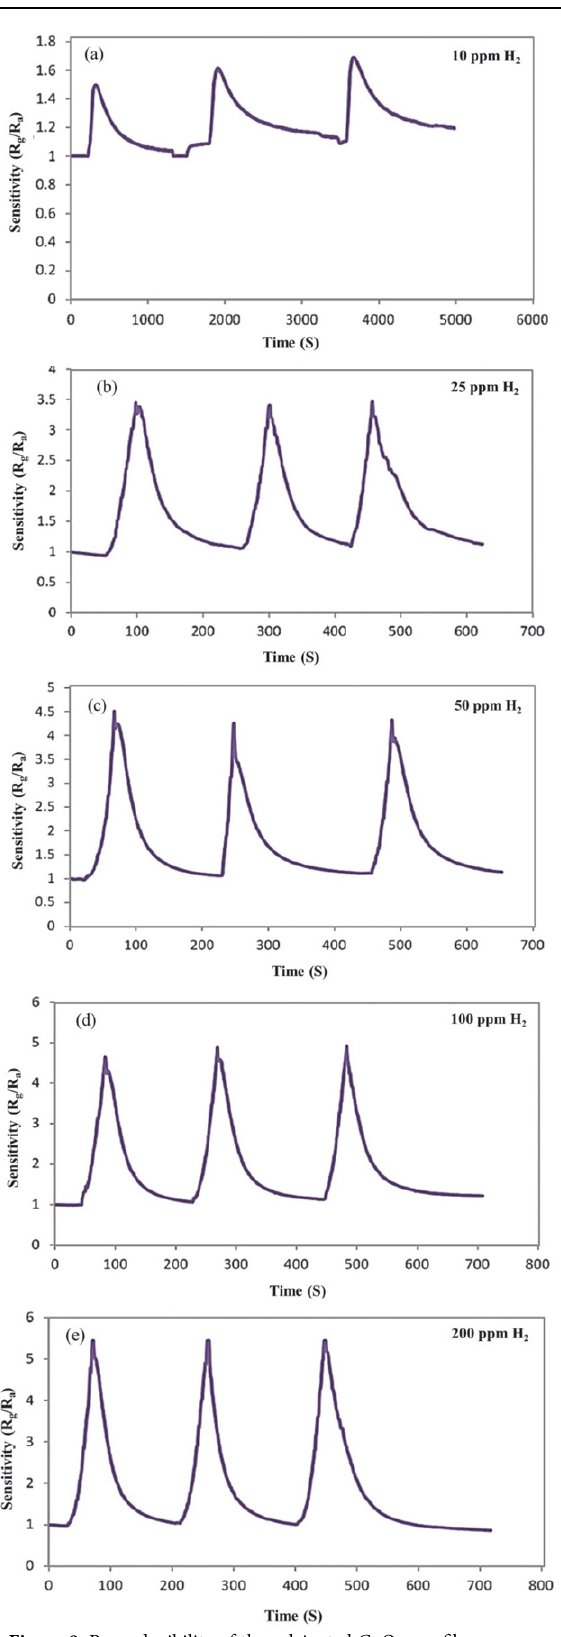
Figure 9 . Reproducibility of the calcinated CuO nanofibers sensor on successive exposure (3 cycles) to (a) 10 ppm (b) 25 ppm (c) 50 ppm (d) 100 ppm (e) 200 ppm of H 2 at 175°C.